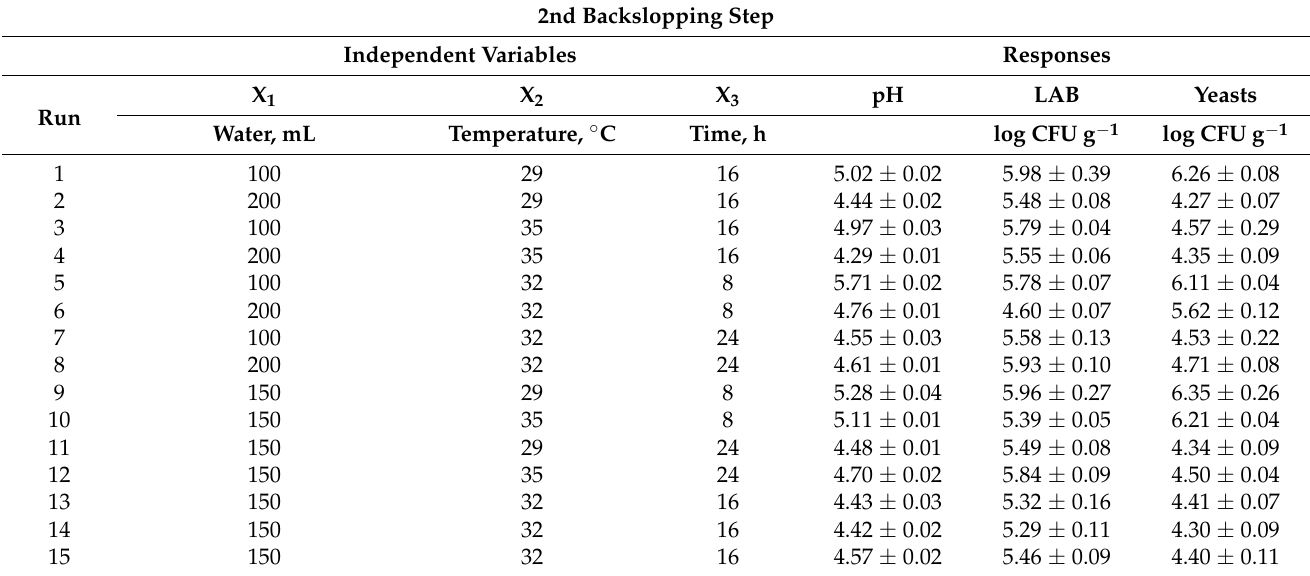
Table 4. The Box–Behnken experimental design and responses in the 2nd backslopping step of fermentation. 2nd Backslopping Step Independent Variables